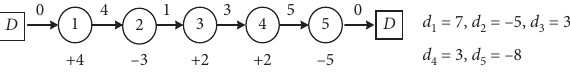
Figure 5: A feasible solution. Figure 6: An infeasible solution with station 6